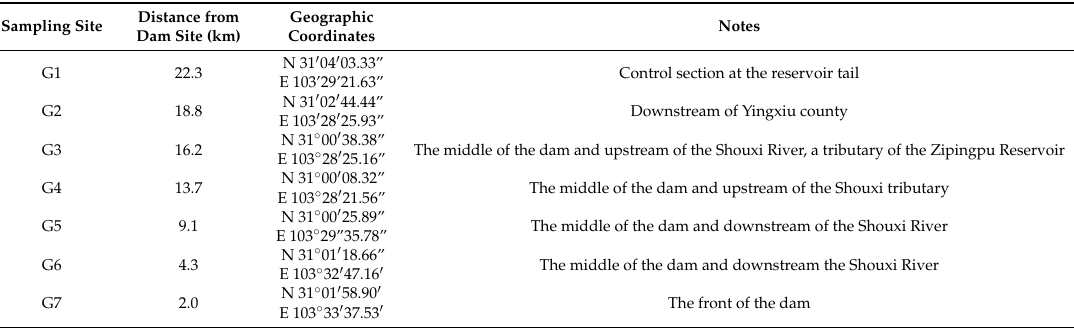
Figure 1. Location of the Zipingpu Reservoir and field sampling site. Table 1. Detailed information on the sampling points in the Zipingpu